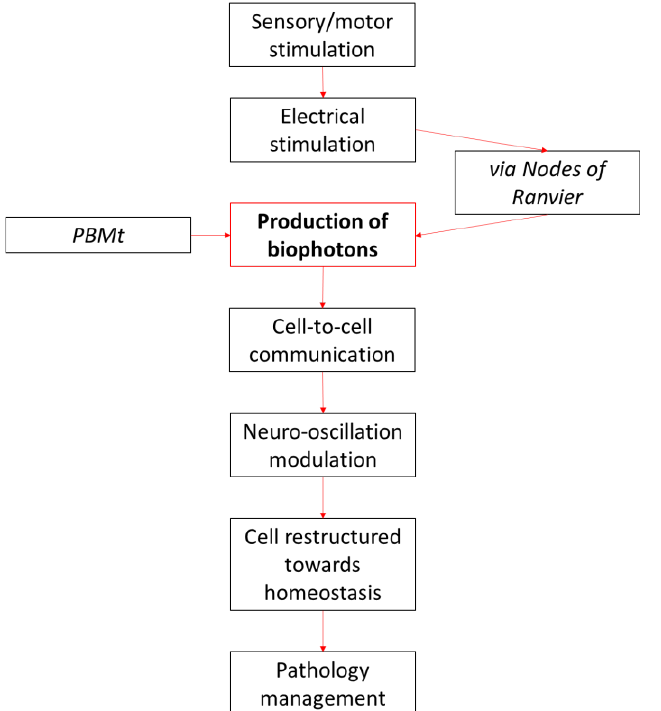
Figure 2. A conceptualization of how biophotons and photobiomodulation may contribute to cell-to-cell communication and the modulation of neural oscillations.